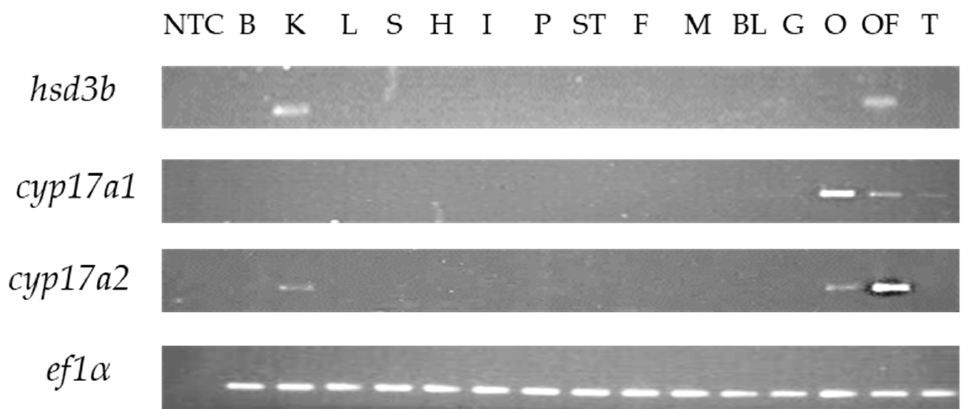
Figure 3. Tissue-specific Amur sturgeon cyp17a1 , cyp17a2, and hsd3b mRNA expression. The expres- sion in 16 tissues of Amur sturgeon is presented. Ef1 α was used as the positive control. NTC, control; B, brain; K, kidney; L, liver; S, spleen; H, heart; I, intestines; P, pyloric appendage; ST, stomach; F, fin; M, muscle; BL, bladder; G, gill; O, ovary; OF, ovarian follicle after removal of yolk; T, testis.